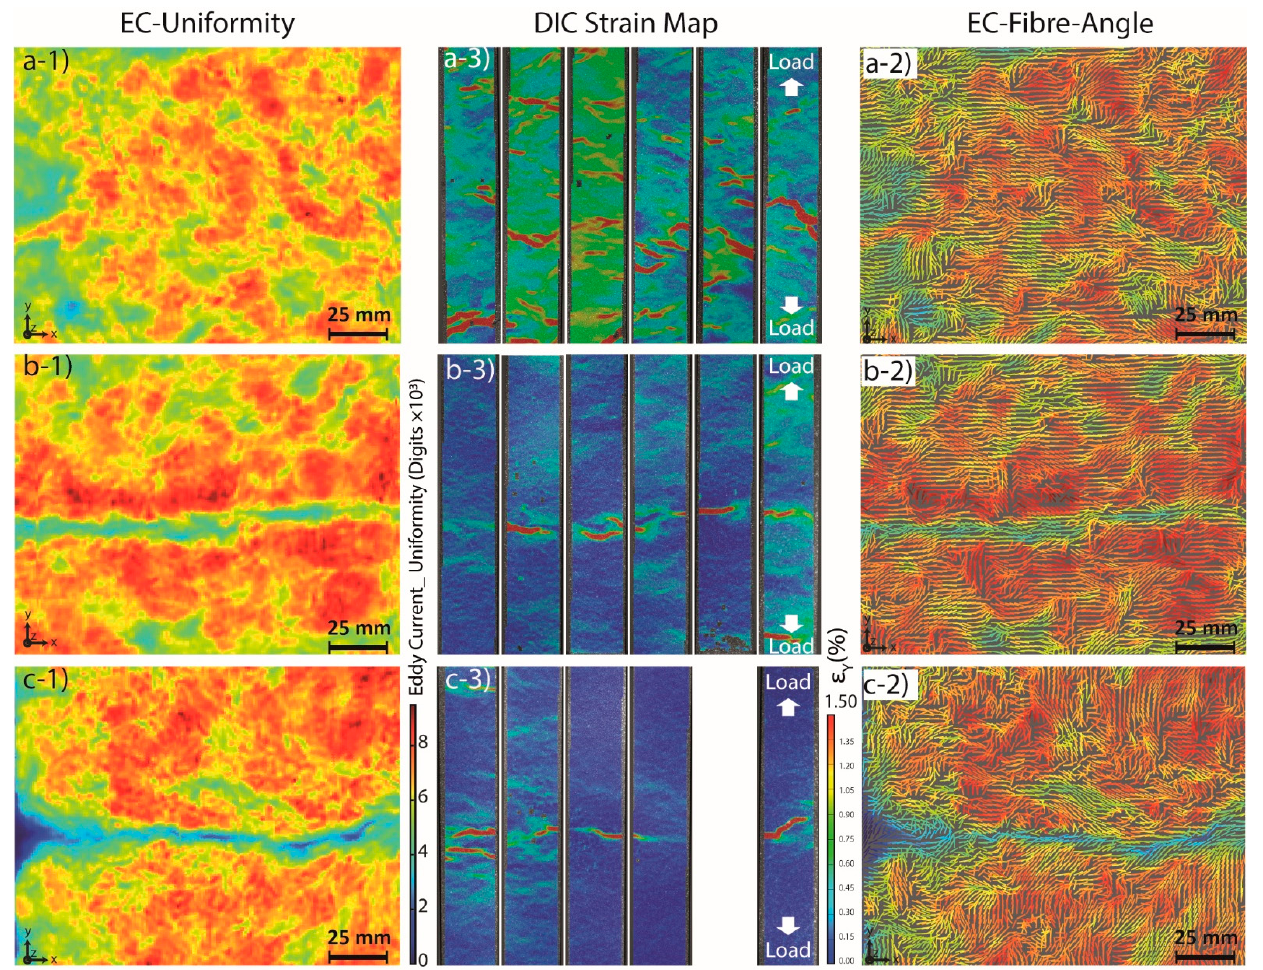
Figure 7. Comparing EC mapping (before testing) with the DIC/mechanical strength of a ( a ) contin- uous (Mono) plaque; ( b ) Butt (low-flow) WLD plaque, ( c ) Flow (high-flow) WLD plaque. ( a , b , c-1 ) EC uniformity; ( a , b , c-2 ) major strain ( Ɛ y ), fixed scale 1.5%; ( a , b , c-3 ) main EC fibre angle with overlaid uniformity colours.